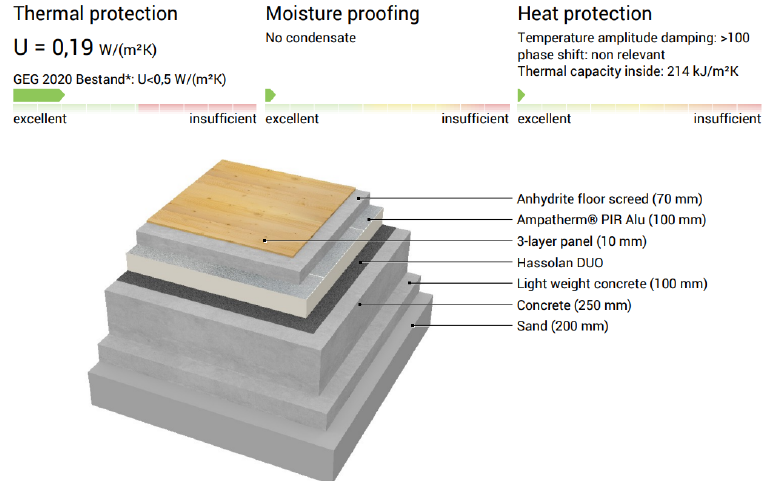
Figure 21. Cross section through the layers of the floor in a wooden frame building according to the applicable building codes regulating the heat transfer coefficient (U) in warm, transitional, and continental climates.